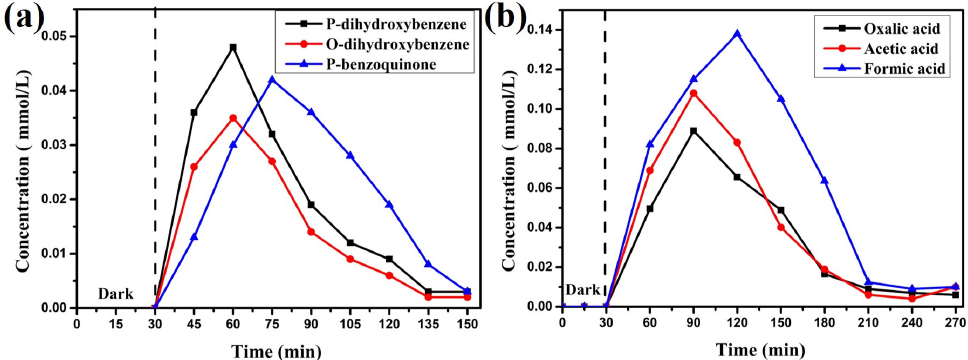
Figure 10. intermediate products ( a , b ) for phenol degradation over non-stacked γ -Fe 2 O 3 /C@TiO 2 . Table 1. Comparison of catalyst performance.